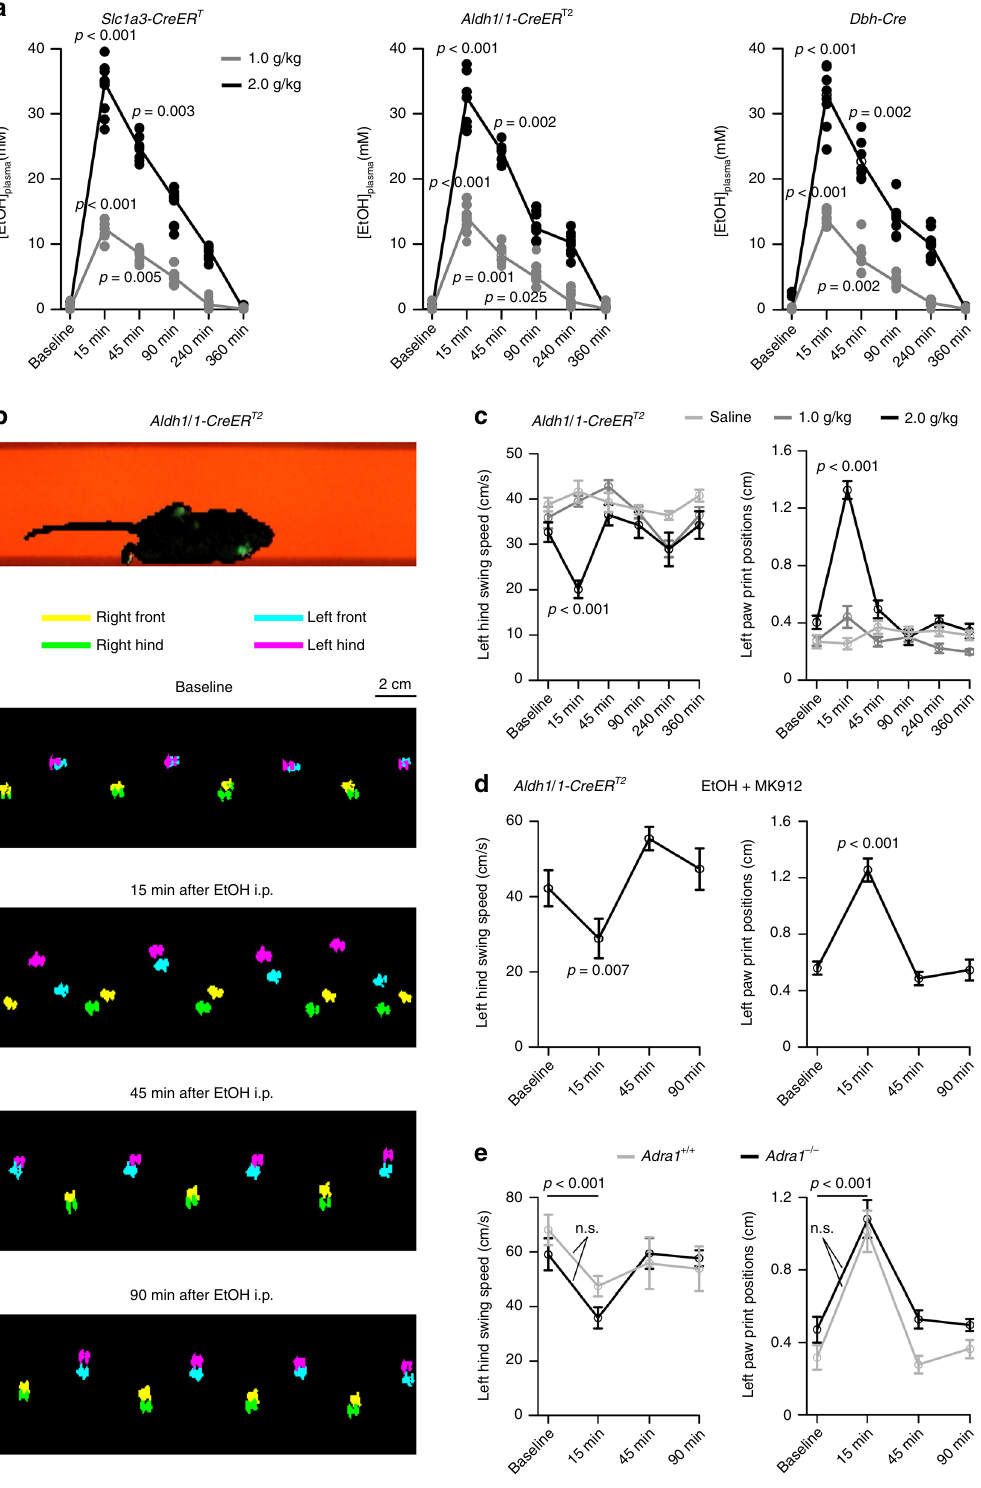
Animals . Mice were kept in the Laboratory Animal Resources facility with the ambient temperature maintained at 72 – 78 °F, the humidity at 30 – 70%, and the mice had ad libitum access to water and chow. Mice were maintained on a reverse 12h-light/12h-dark schedule (lights off at 9 a.m., on at 9 p.m.) and all experimental procedures were completed during the dark cycle. The transgenic mouse breeding strategy followed the following rules: For all experiments either GCaMP3, GCaMP6f (Ai95 (ref. 70 )) or Lck-GCaMP6f was expressed as GECI in a Cre-dependent manner. For the parameters analyzed in this study, the slight differences in kinetics between astroglia Ca 2 + dynamics measured